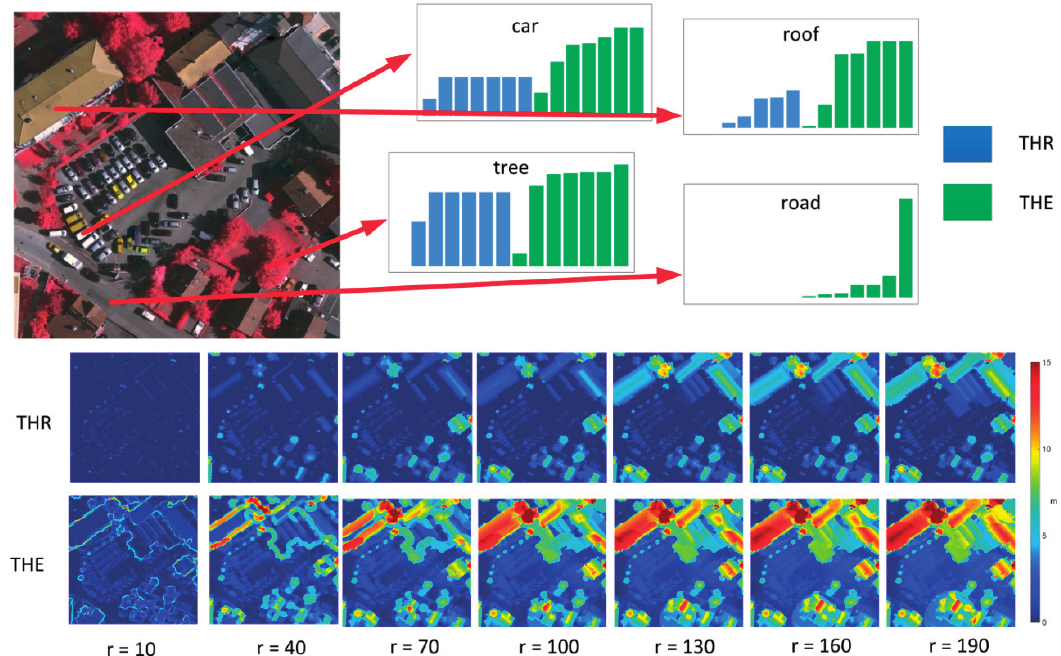
Figure 2. The THR and THE values at different scales for difference urban classes in the ultra-high resolution (UHR) image. “r” is the size of the structuring element (SE) in pixels. Given a set of training samples for (cid:1840) classes {∁ (cid:2869) } (cid:3041) segment in the image space specifying a sample for class ∁ (cid:3040) , we compute its scale (cid:2285)((cid:1855) (cid:3036)(cid:3040) )